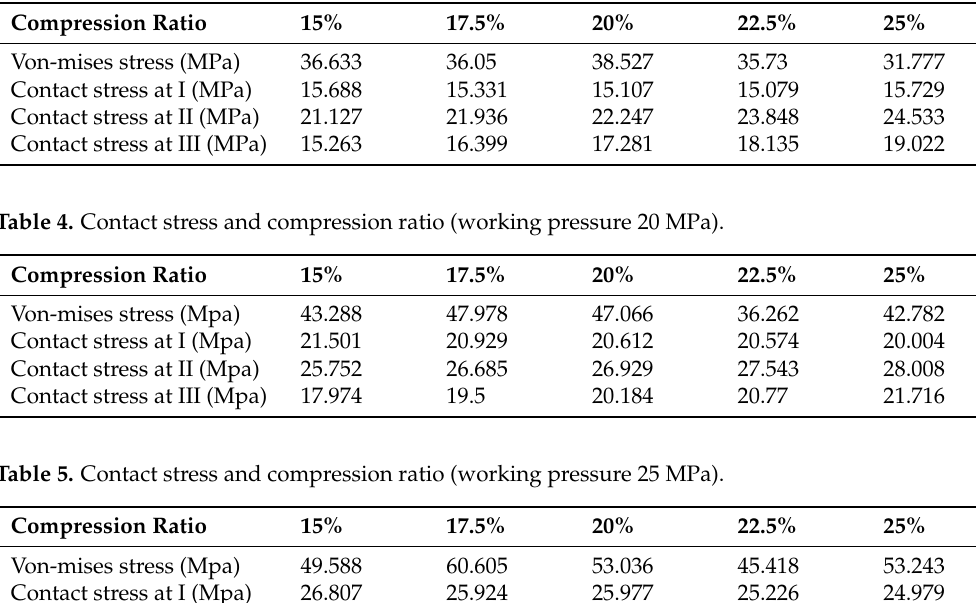
Table 3. Contact stress and compression ratio (working pressure 15 MPa).